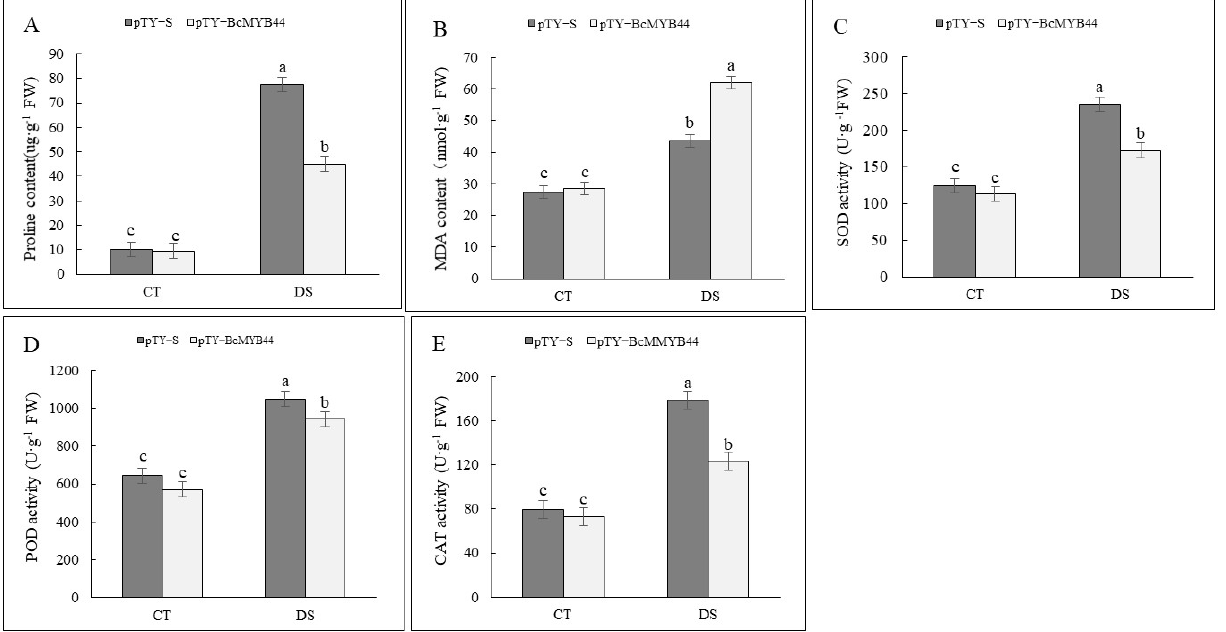
Figure 10. Changes of some substances in non-heading Chinese cabbage under drought stress, including proline ( A ), malondialdehyde ( B ), SOD ( C ), POD ( D ), CAT ( E ) enzyme activity. CT—control, DS—drought stress. Note: Different lowercase letters indicate significant difference ( p < 0.05).